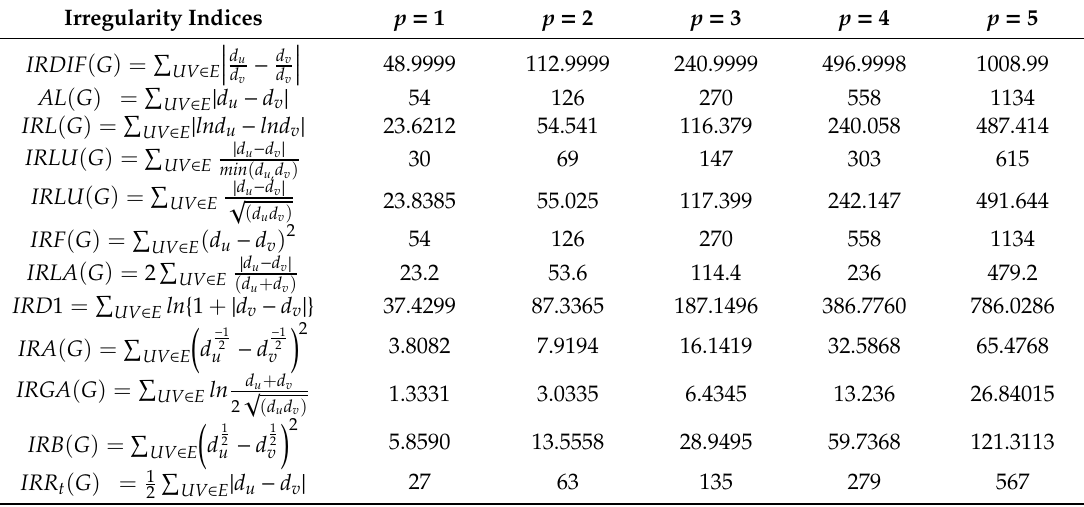
Table 6. Irregularity indices for NS 3 [ p ] polymer